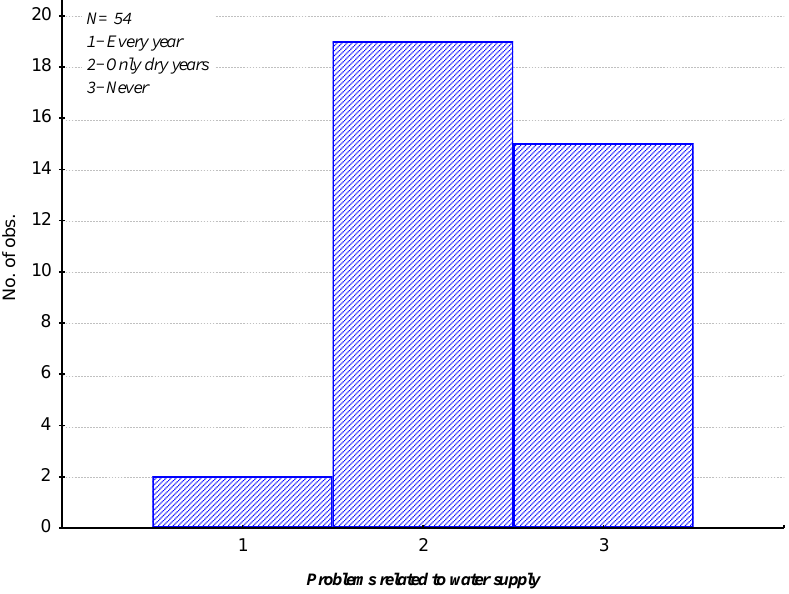
Figure 2. Temporal frequency of problems related to water supply in Extremenian rangelands.